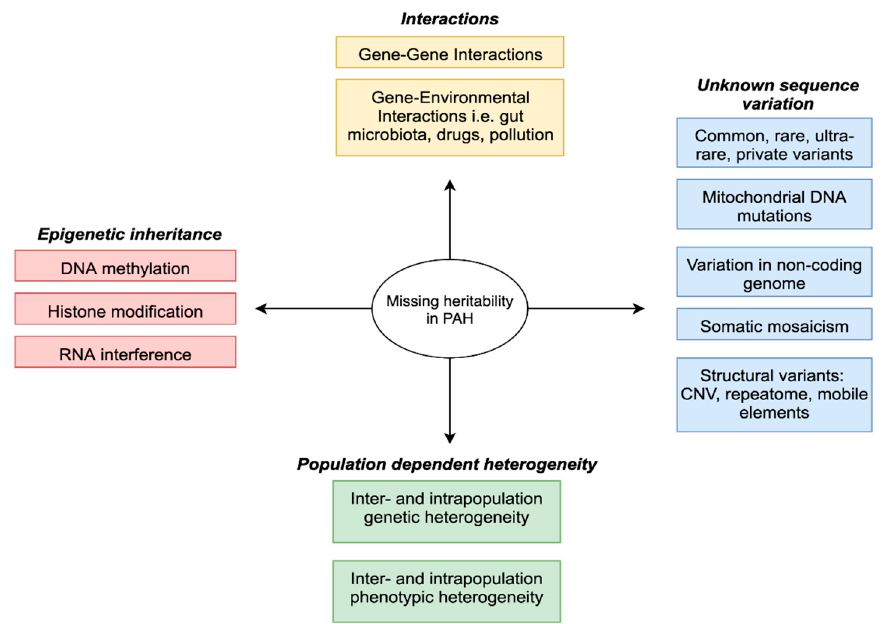
Figure 2. Potential factors contributing to missing heritability in PAH.